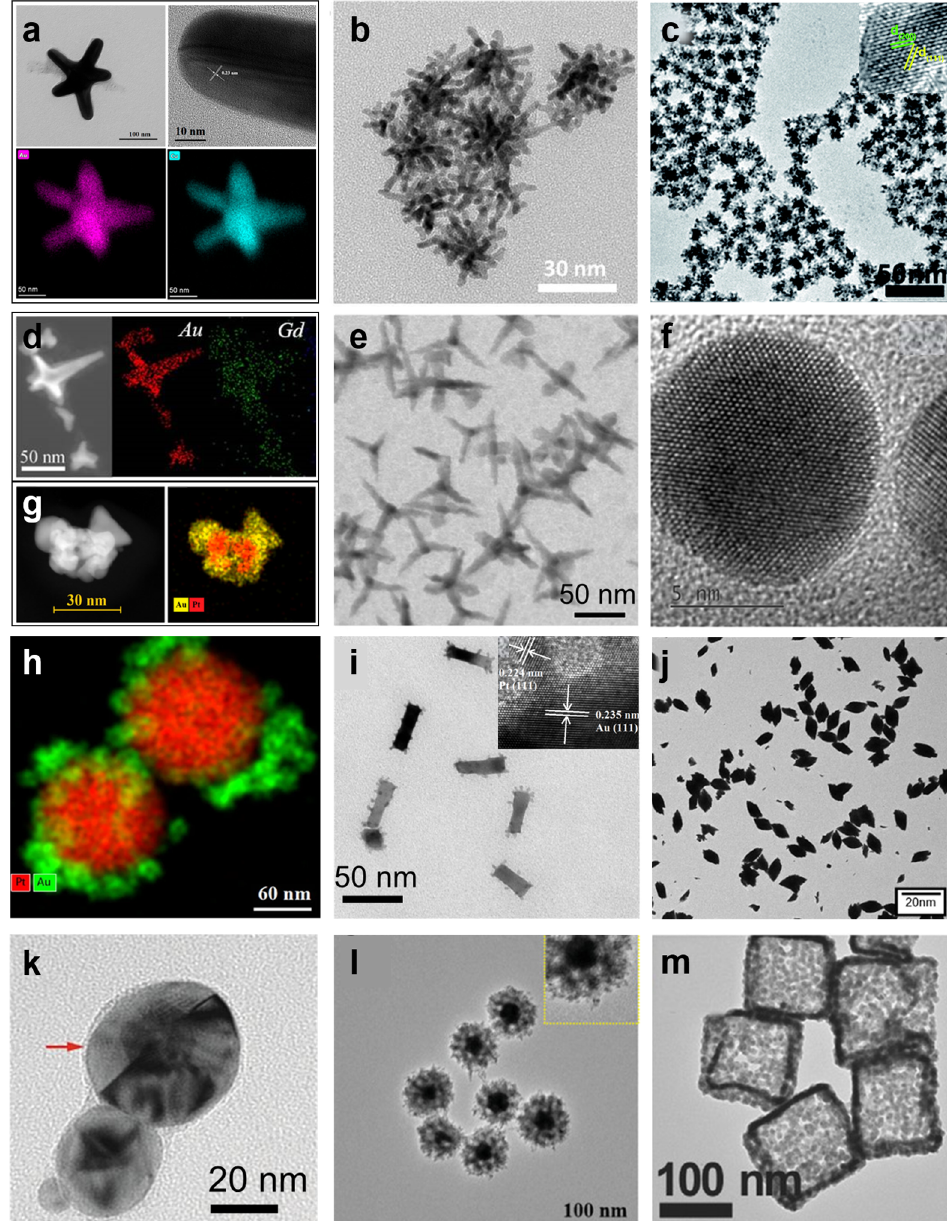
Figure 2. Morphologies and structures of different BMNs. ( a ) Characterization of ATP@Au–Cu NP (TEM, HR-TEM, and EDS). Reprinted with permission from Ref. [59]. Copyright © 2022 American Chemical Society. ( b ) TEM image of Au@Pt NDs. Reprinted with permission from Ref. [62]. Copyright © 2016 American Chemical Society ( c ) TEM image and HR-TEM of Au-Pt NDs. Adapted with permission from Ref. [60]. Copyright © The Royal Society of Chemistry 2015. ( d ) The TEM image and EDS images of AuNS@CP (space between black and white lines indicates CP layer). Reprinted with permission from Ref. [61]. Copyright ©2022 Ivyspring International Publisher. ( e ) TEM image of Cu–Pd alloy TNP. Reprinted with permission from Ref. [63]. Copyright © 2022 Springer Nature Limited. ( f ) HR-TEM of Ag–Au alloy NP. Reprinted with permission from Ref. [19]. Copyright © 2019 Elsevier B.V. ( g ) TEM image and EDS image of gold-decorated platinum NPs. Reprinted with permission from Ref. [64]. Copyright © 2021 MDPI. ( h ) EDS image of platinum–gold nanoraspberries. Reprinted with permission from Ref. [65]. Copyright © 2019 Springer Nature. ( i ) TEM image of